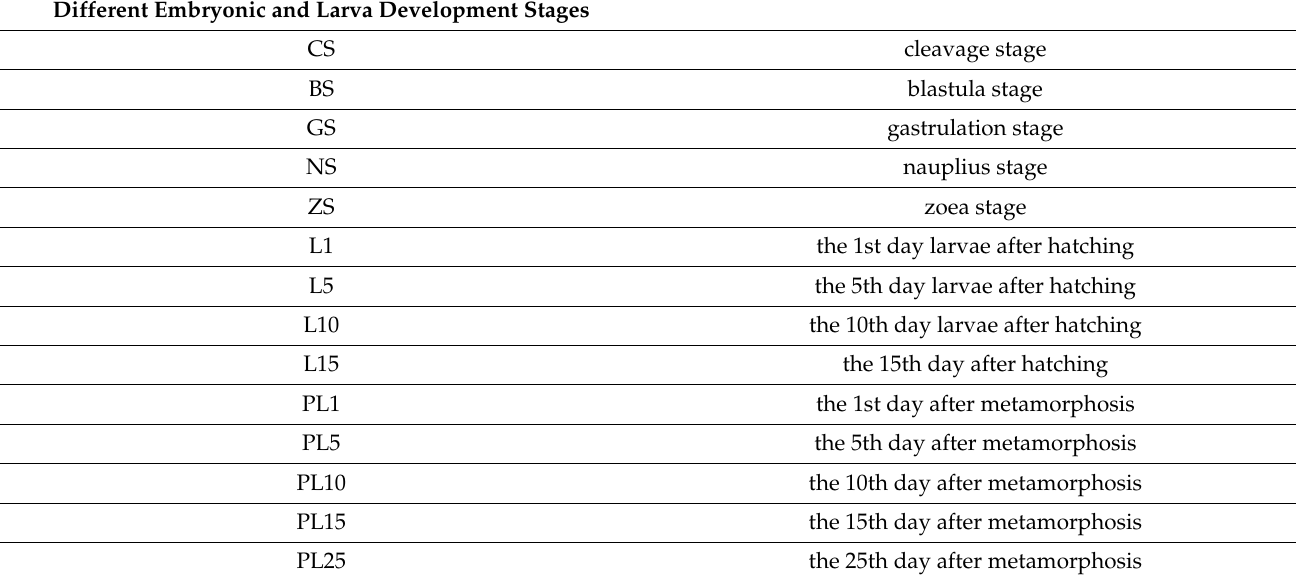
Table 2. Different embryonic and larva development stages of M. nipponense . Different Embryonic and Larva Development Stages